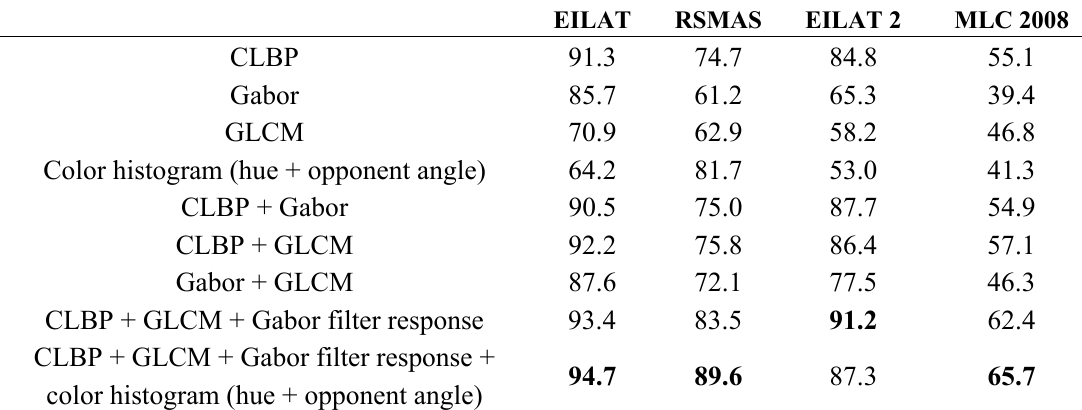
Table 5. Overall accuracy (%) with different feature extraction methods as evaluated with the EILAT, RSMAS, EILAT 2 and MLC 2008 datasets. In this experiment, fixed configurations on the rest of the steps are as follows. Image enhancement: contrast limited adaptive histogram specification (CLAHS); kernel mapping: L1 normalization; dimension reduction: principal component analysis (PCA); prior: Class frequency; classifier: k-nearest neighbor (KNN). Different combinations of completed local binary pattern (CLBP), grey level co-occurrence matrix (GLCM), Gabor filter response and color histogram (hue + opponent angle) are evaluated in this experiments.